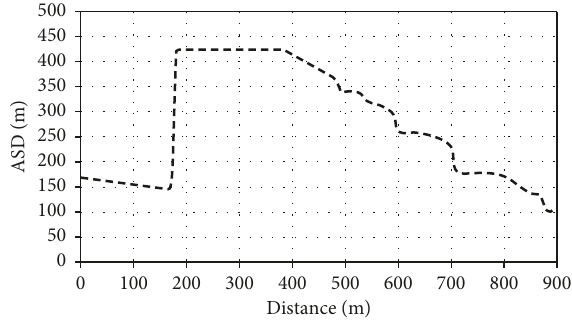
Figure 7: Measurement result of 3D ASD on a horizontal curve.